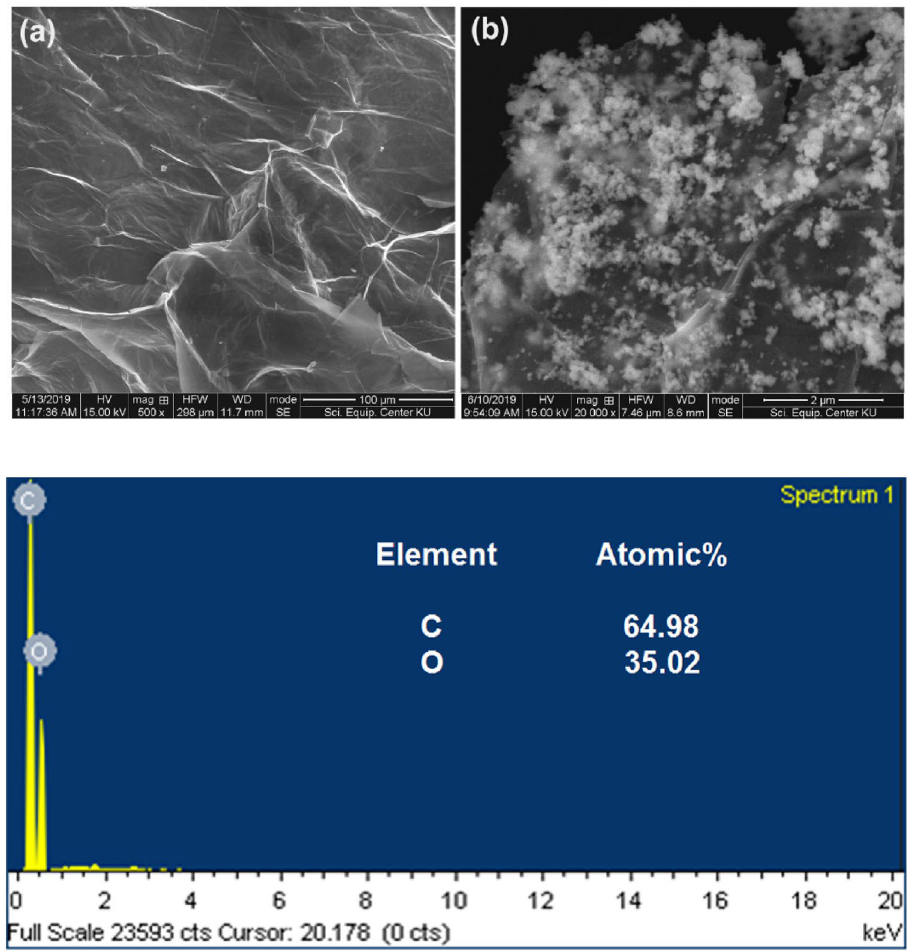
Fig. 2 SEM images of GO and Mn